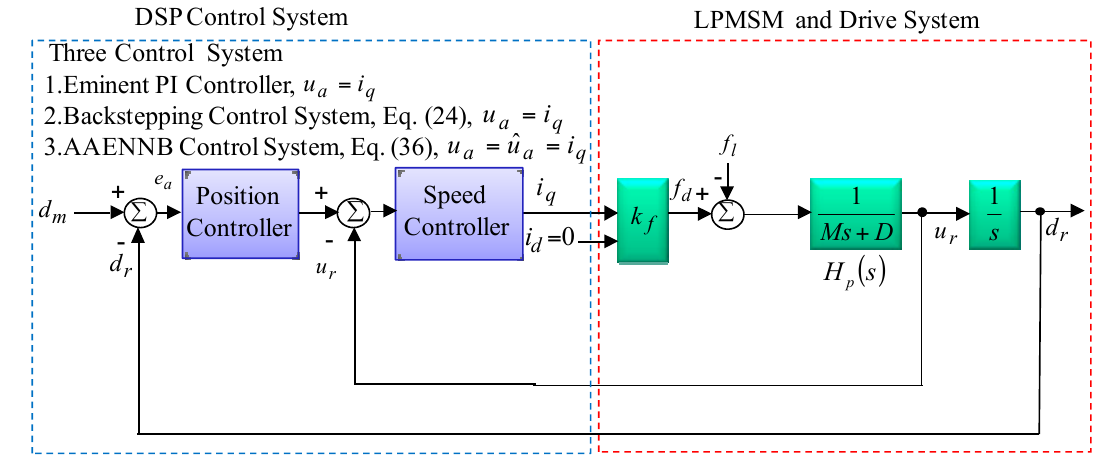
Figure 2. Simplified block diagram of the LPMSM drive and control system.